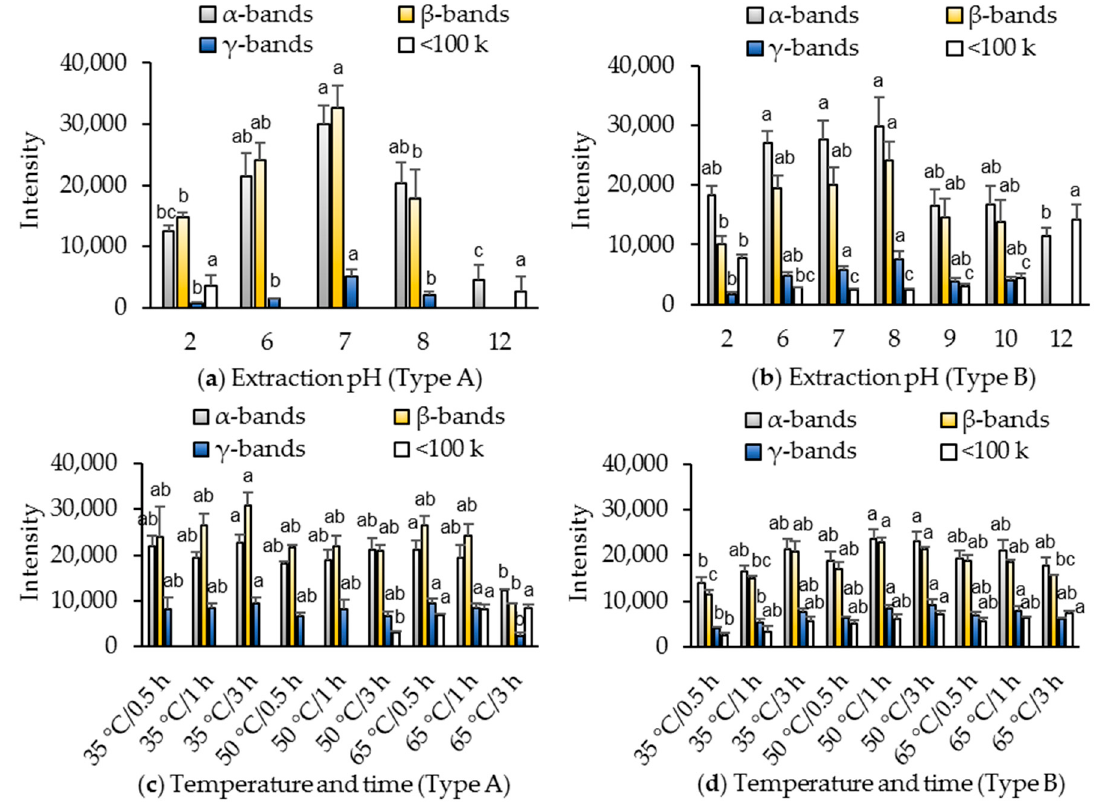
All values are the mean ± standard error of three replicates. Different letters in the superscript of each column show significant difference ( p < 0.05) for each extraction process at different conditions.